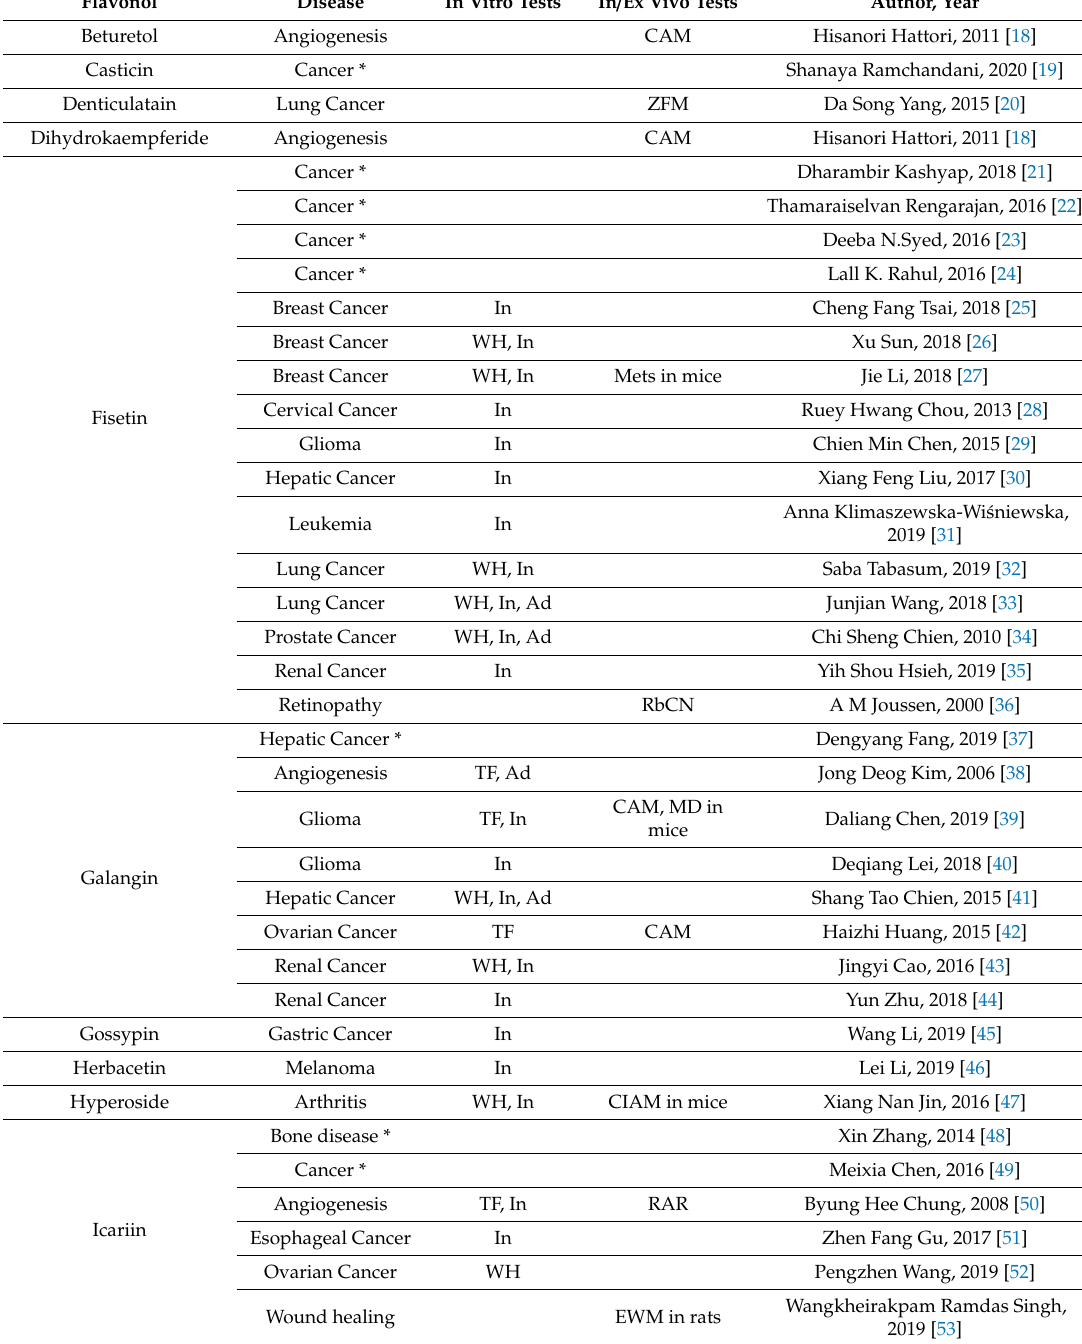
Table 1. Characteristics of the studies included in Section 1 for flavonols subclass (see Table S1 for all 9